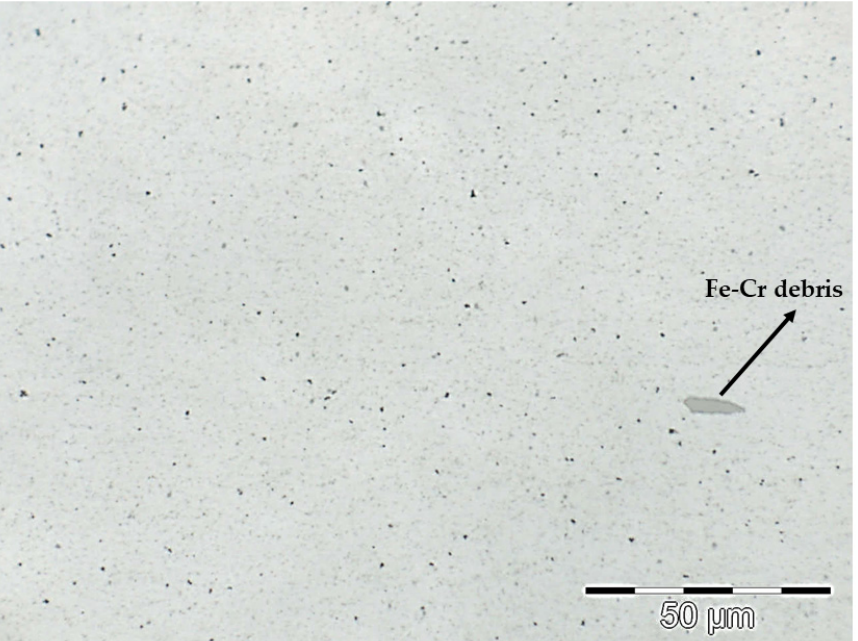
Figure 13. Transverse section of the 7075-0.5 wt.% MWCNTs showing full densification of the composite. The presence of a Fe-Cr inclusion from the milling balls and intermetallic phases can be noticed.